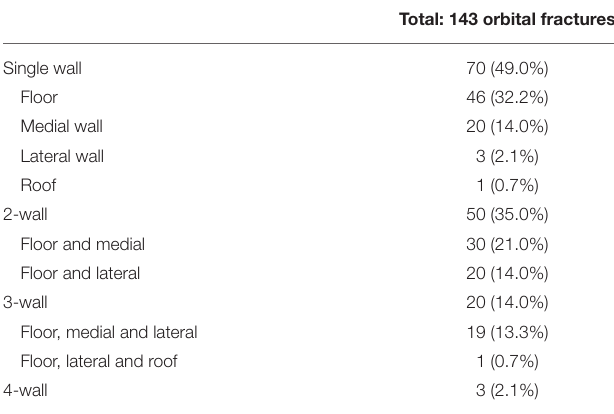
TABLE 2 | Number of orbital walls involved in